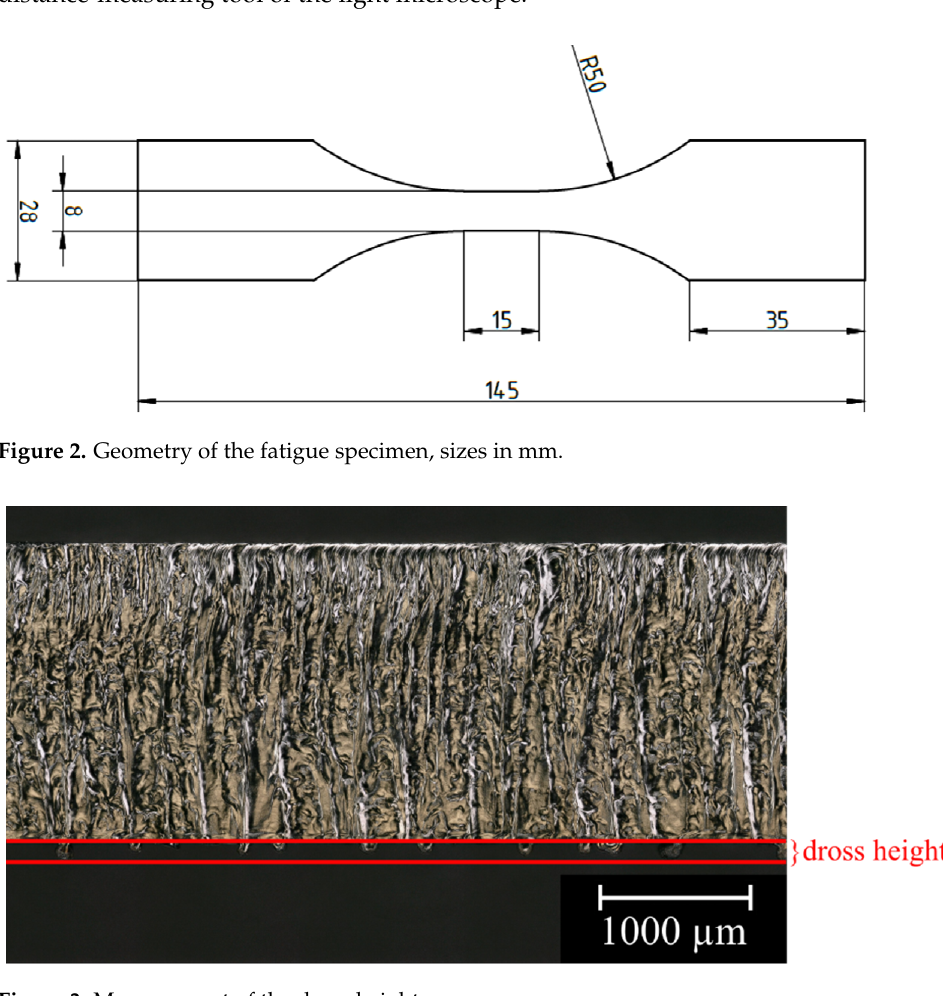
Figure 3. Measurement of the dross